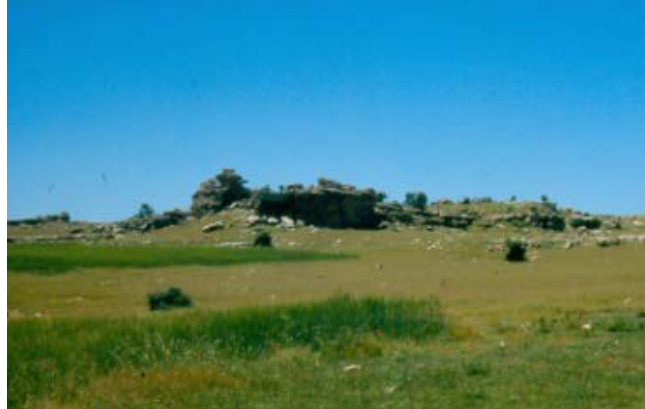
Figure 4. Tidrit rock-shelter (photo Searight).